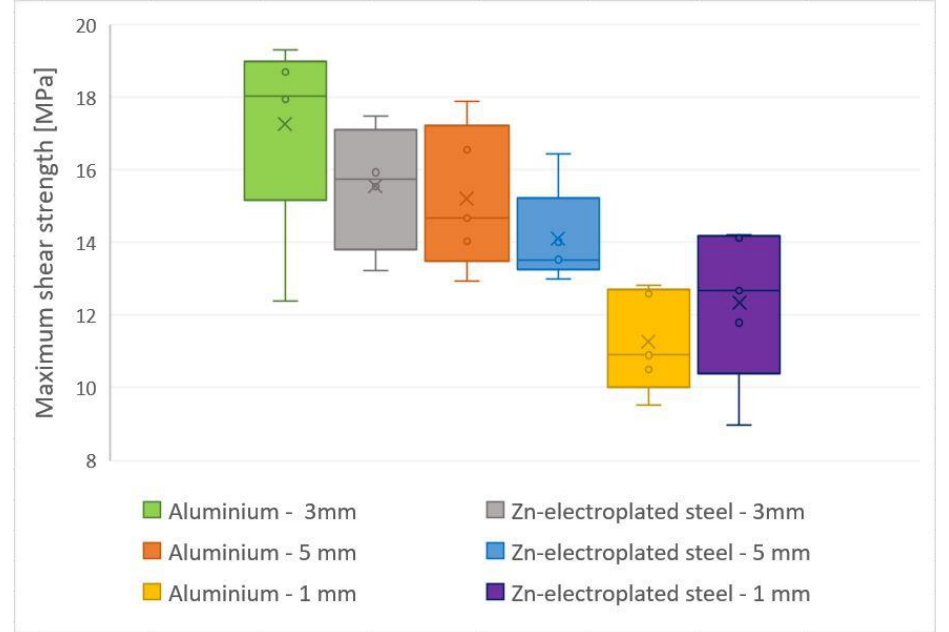
Fig. 5 Maximum shear strength for reference set of